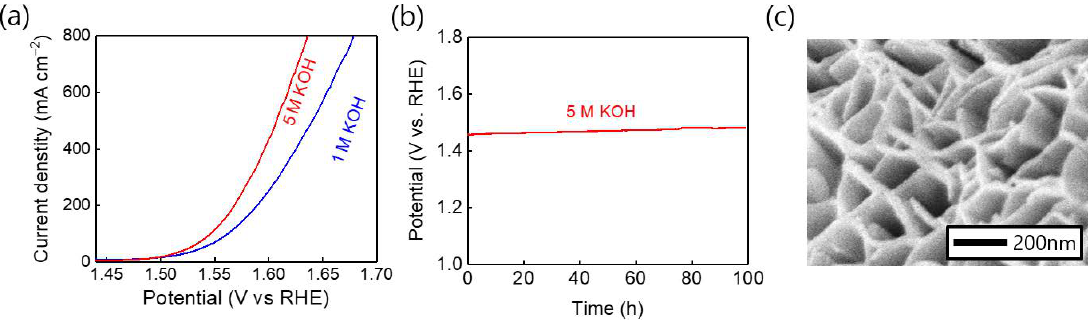
Figure 8. ( a ) LSV curves (85% IR -compensated) for CCO-250 ◦ C in 1 and 5 M KOH at room temperature. ( b ) Chronopoten- tiometry curve of CCO (250 ◦ C) at a current density of 20 mA cm − 2 in 5 M KOH for 100 h. ( c ) SEM image showing the surface morphology of CCO (250 ◦ C) after durability